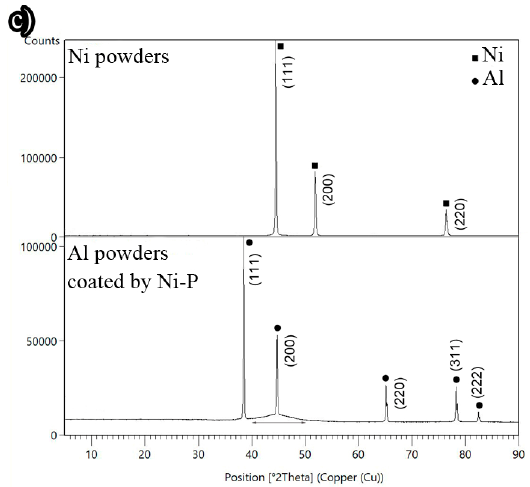
Figure 1. SEM micrographs of the electroless Ni-P coating for ( a ) Co and ( b ) Al particles; ( c ) XRD patterns of the ENP coated Al and metallic Ni powders.